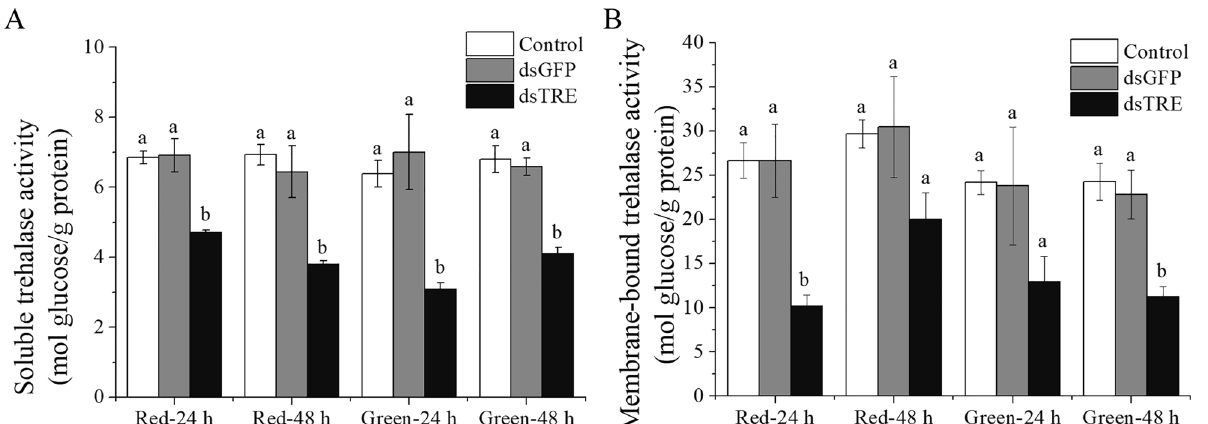
Figure 2. The enzyme activity of trehalase at 24 h and 48 h after RNAi. ( A ) The soluble trehalase activity after RNAi, ( B ) the membrane-bound trehalase activity after RNAi. Control the normal diet, dsGFP the GFP-dsRNA treatment, dsTPS the TPS-dsRNA treatment, dsTRE the TRE-dsRNA treatment, Red red morphs of A. pisum , Green green morphs of A. pisum . Each bar represents the Means ± SEM from three biological replicates with ten individuals mixed in each replicate. The data were analyzed using one-way analysis of variance (ANOVA), followed by the Tukey–Kramer test. The enzyme activity in the artificial diet group was designated as control, and different letters above the error bars indicate significant differences ( P <